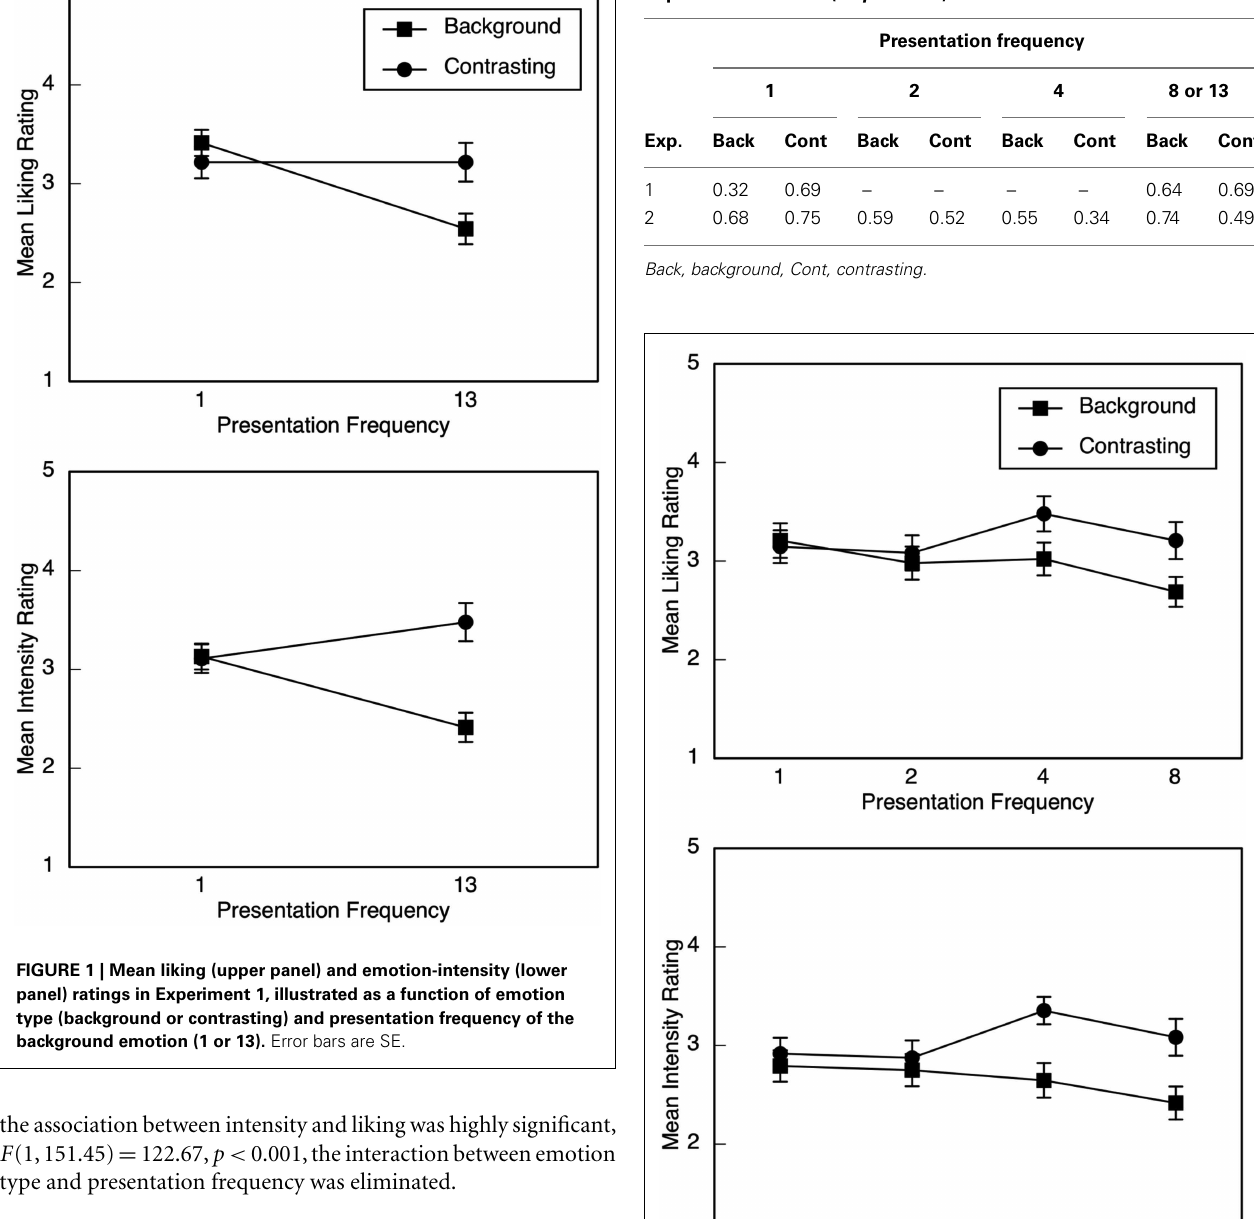
approached significance after four presentations, F (1, 46) = 3.66, p = 0.062, partial η 2 = 0.07, and differed significantly after eight presentations, F (1, 46) = 5.17, p = 0.028, partial η 2 =